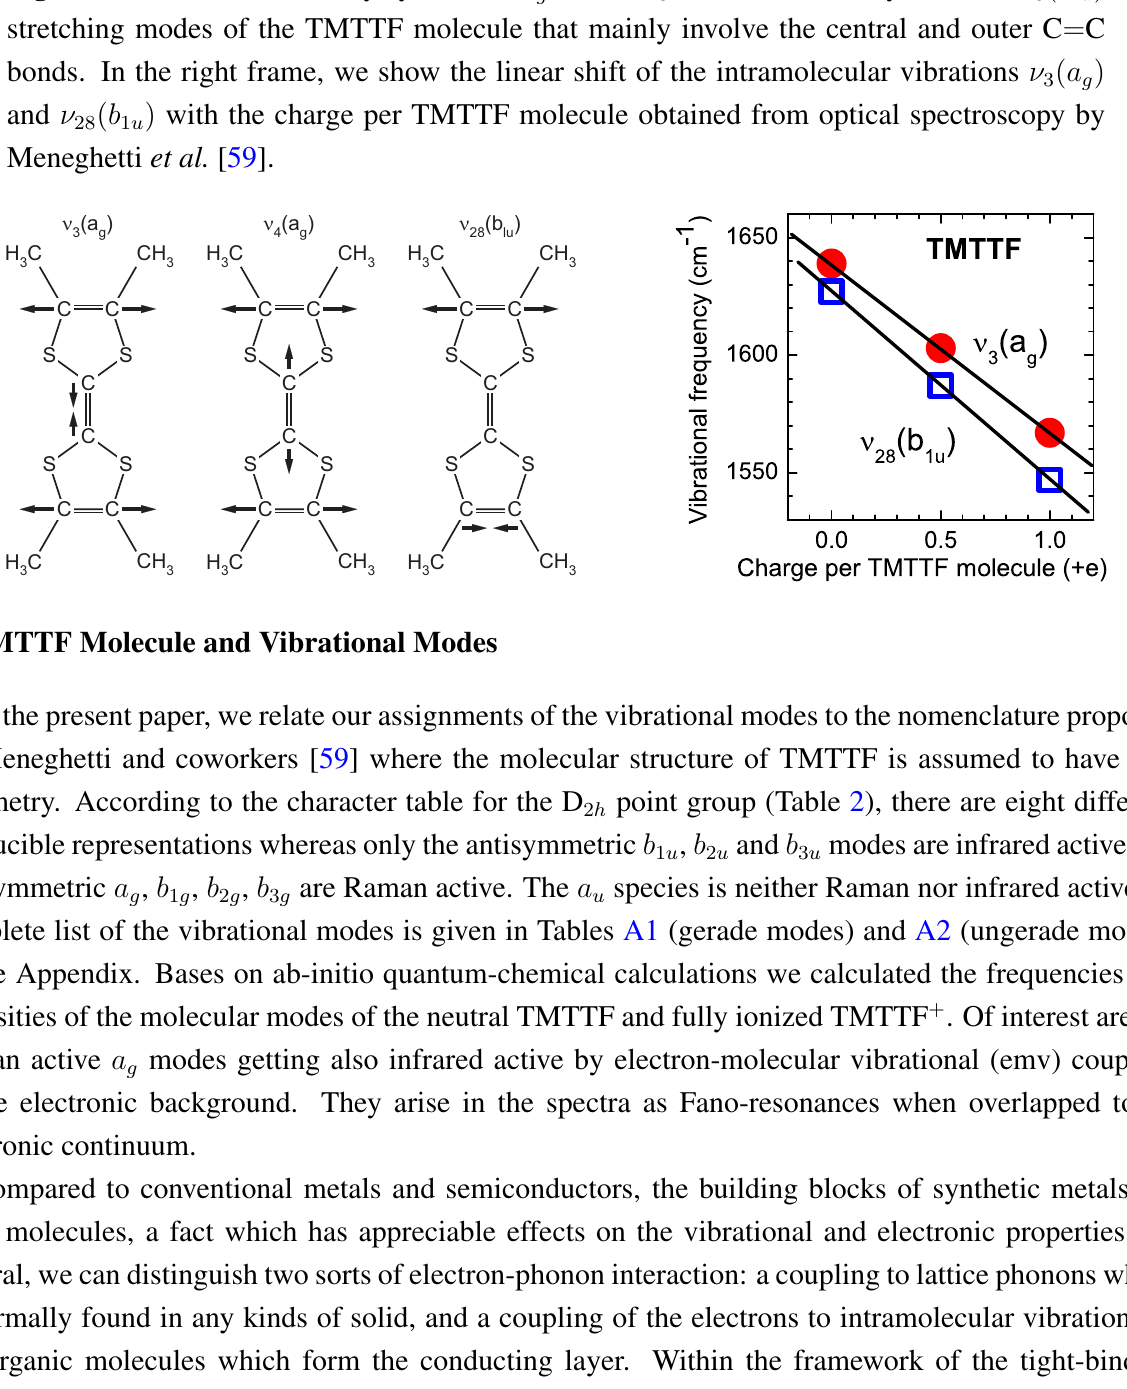
modes ν and ν and the asymmetric ν g 3 4